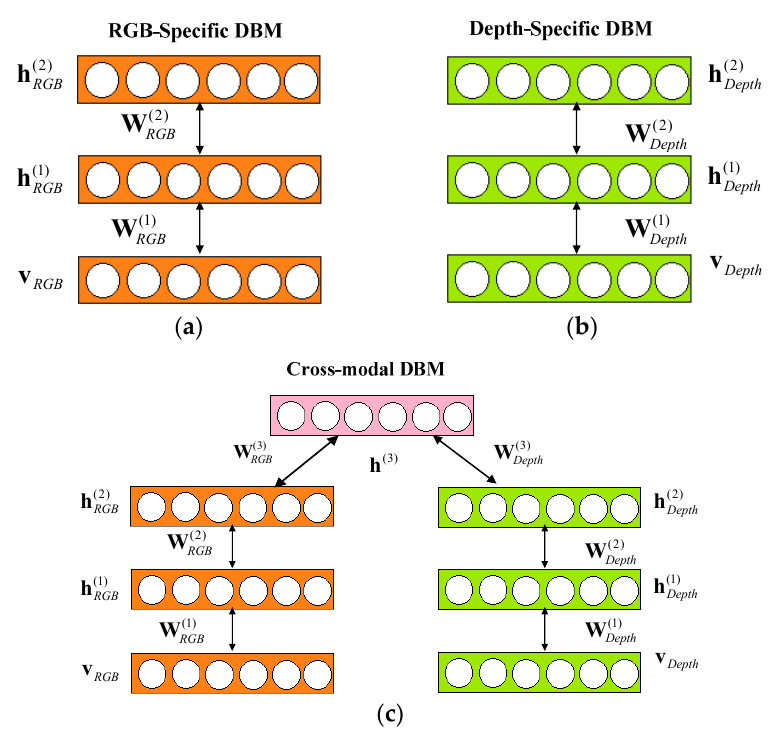
Figure 4. The illustration of the proposed cross-modal Gaussian-Bernoulli DBM. ( a ) RGB-specific two-layer Gaussian-Bernoulli DBM; ( b ) Depth-specific two-layer Gaussian-Bernoulli DBM; ( c ) a Cross-modal Gaussian-Bernoulli DBM.